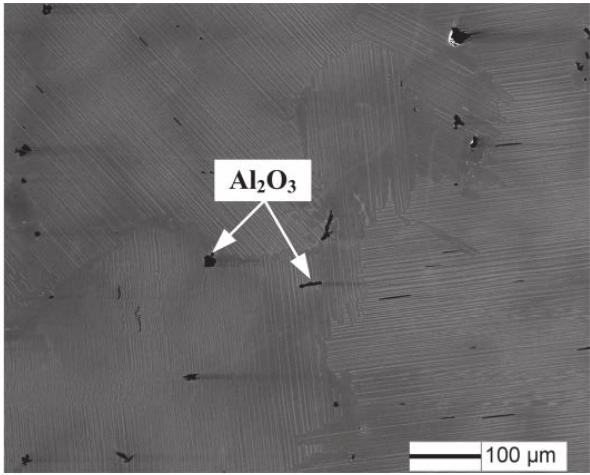
Fig. 8: Inclusions inside the alloy matrix obtained by zirconia mould.